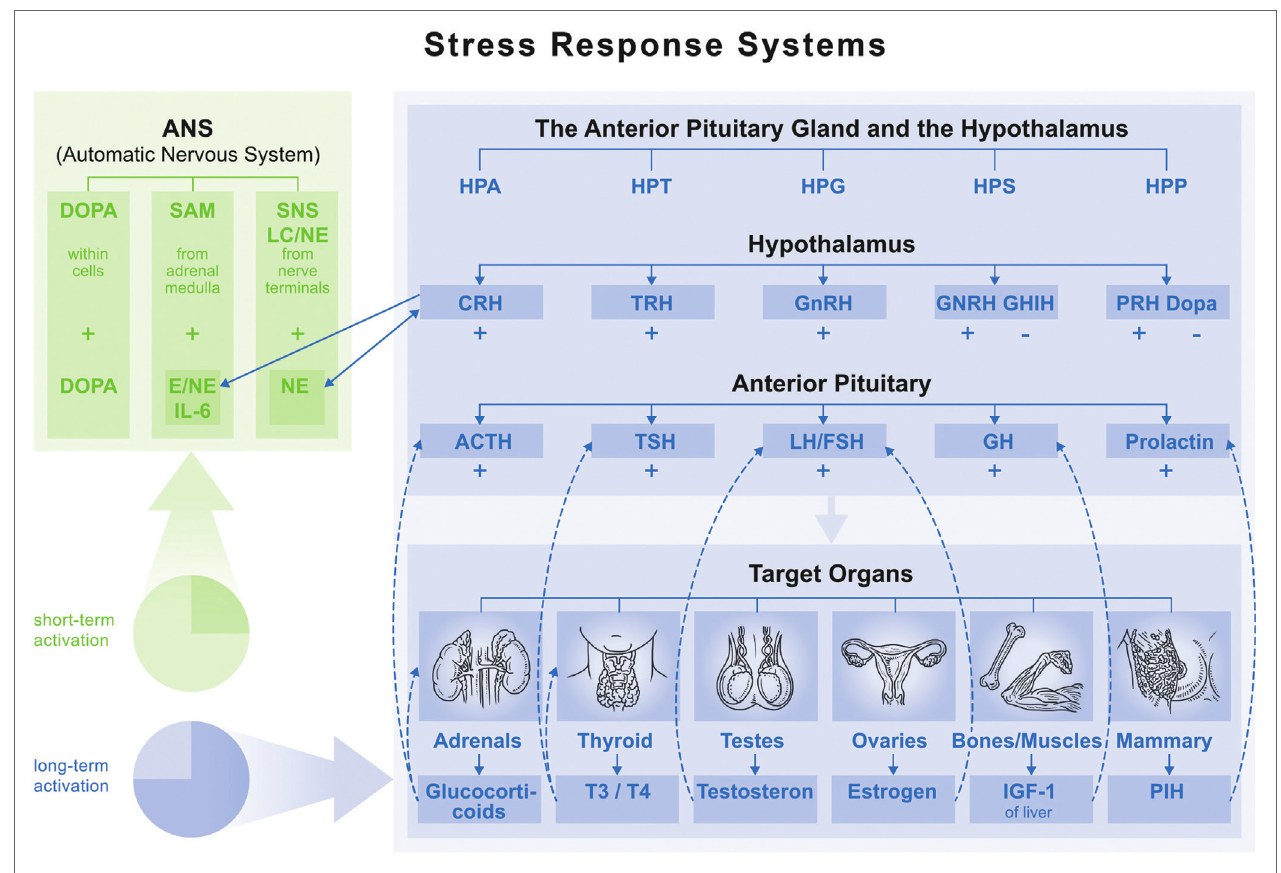
FigURe 1 | Overview of main endocrine axes . Normal function: feedback loop stops activation on each axis. Maladaptation of feedback function leads to fluctuation (accumulation) in one axis (hyper- or hypofunction), which influences function of the others. ⇢ = inhibition; → = stimulation. Abbreviations: HPA, hypothalamic–pituitary–adrenal; HPT, hypothalamic–pituitary–thyroid; HPG, hypothalamic–pituitary–gonadal; HPS, hypothalamic–pituitary–somatotropic; HPP, hypothalamic–pituitary–prolactin; CRH, corticotropin-releasing hormone; TRH, thyrotropin-releasing hormone; GnRH, gonadotropin-releasing hormone; GHRH, growth hormone-releasing hormone; GHIH, growth hormone-inhibiting hormone; DOPA, dopamine; ACTH, adrenocorticotropic hormone; TSH, thyroid-stimulating hormone; LH, luteinizing hormone; FSH, follicle-stimulating hormone; GH, growth